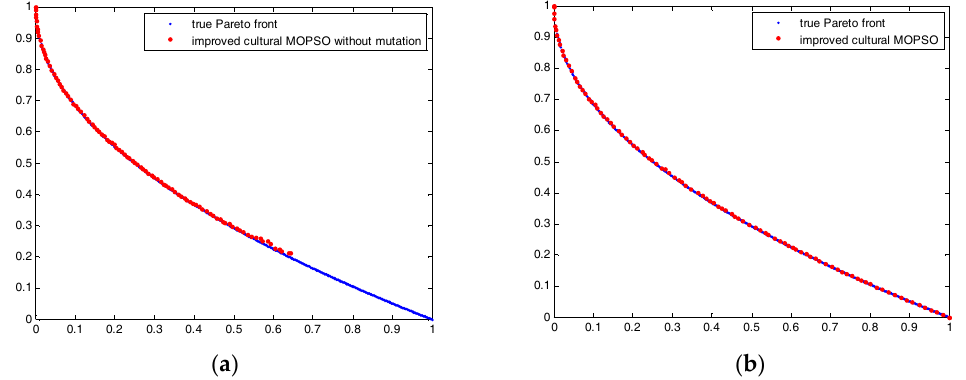
Figure 8. Pareto fronts for ZDT1: ( a ) the Pareto fronts obtained without using the mutation operator; ( b ) the Pareto fronts obtained using the mutation operator.